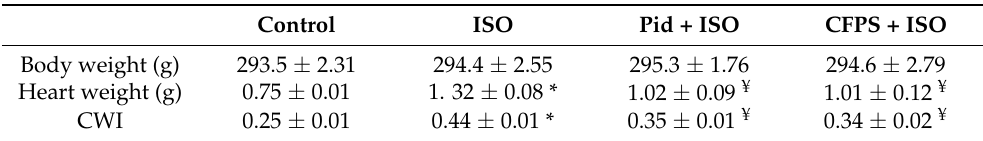
Table 3. Effect of CFPS fraction on body weight, heart weight, and cardiac weight index (CWI) of control and experimental groups of rats.